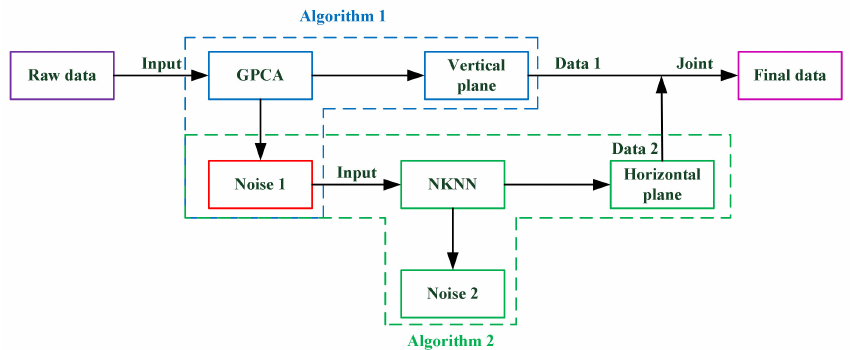
Figure 1. The general idea of the filtering method is presented. Algorithm 1 is used to process the initial data, and the wall point cloud and noise 1 are obtained. Noise 1 is composed of the ground point cloud and noise. Then, Algorithm 2 is used to process noise 1, and the ground point cloud and noise are separated. Finally, the wall and the ground are joined